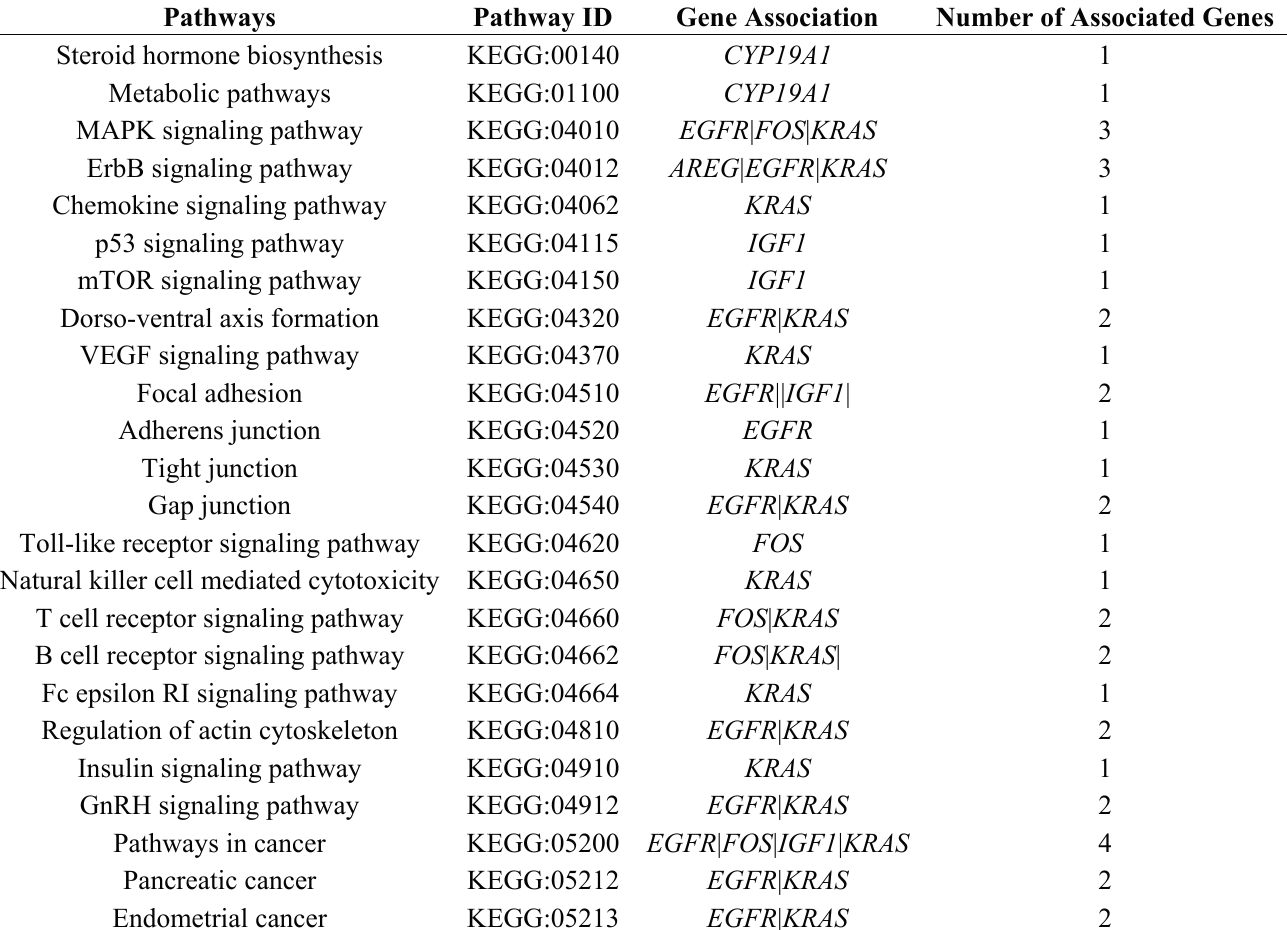
Table 3. KEGG enrichment pathways for common genes between EDCs, breast cancer and